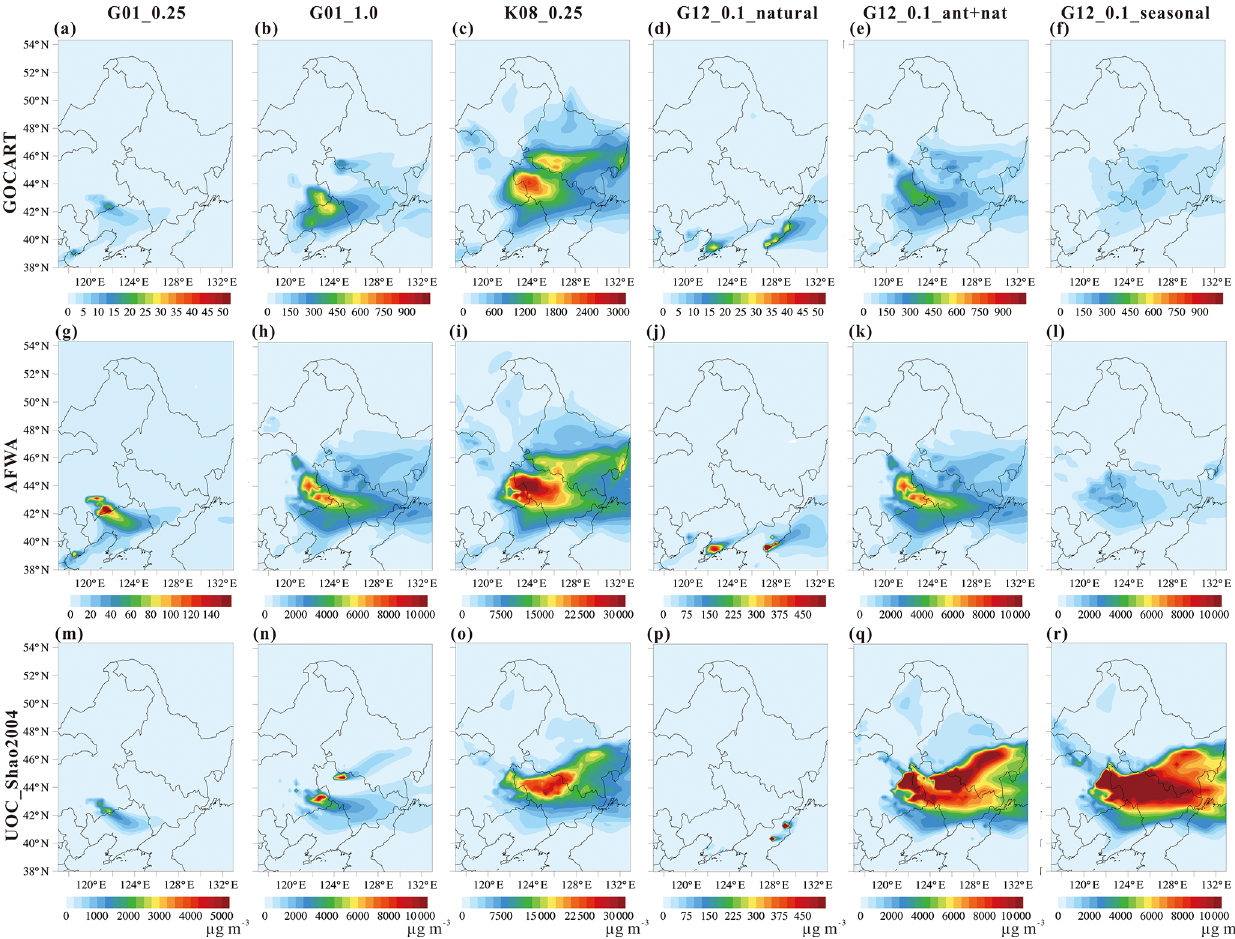
Figure 5. Daily mean PM 10 distributions in NEC on 5 May 2015 using GOCART, AFWA, and UOC_Shao2004 with each source map; (a–e) GOCART, (g–l) AFWA, and (m–r)